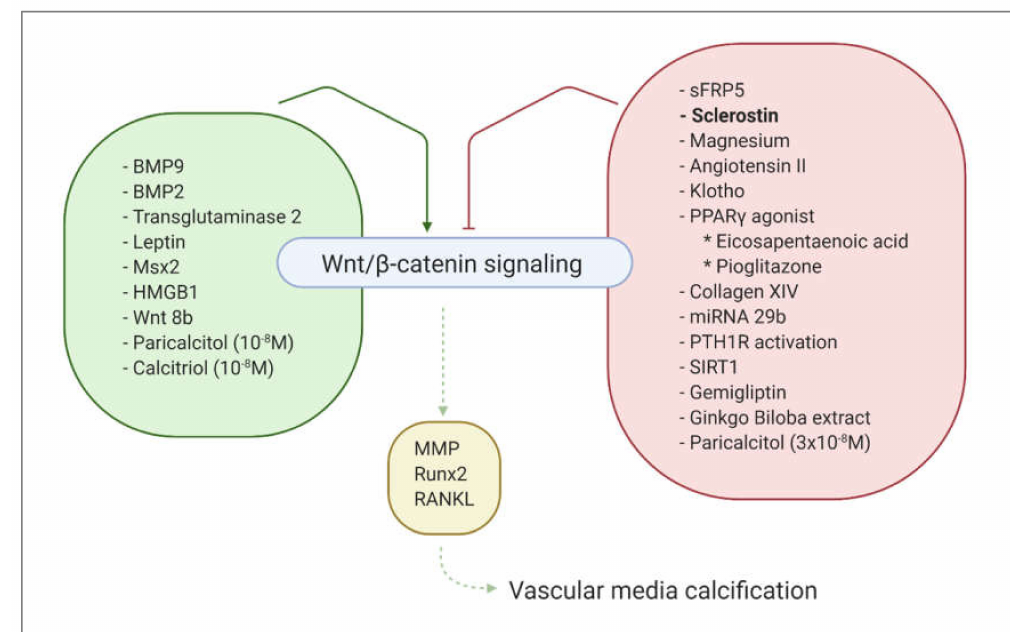
Figure 2. Overview of activators and inhibitors of Wnt / β -catenin signaling pathway. BMP9: Bone-Morphogenetic Protein 9, BMP2: Bone-Morphogenetic Protein 2, Msx2: Msh homeobox